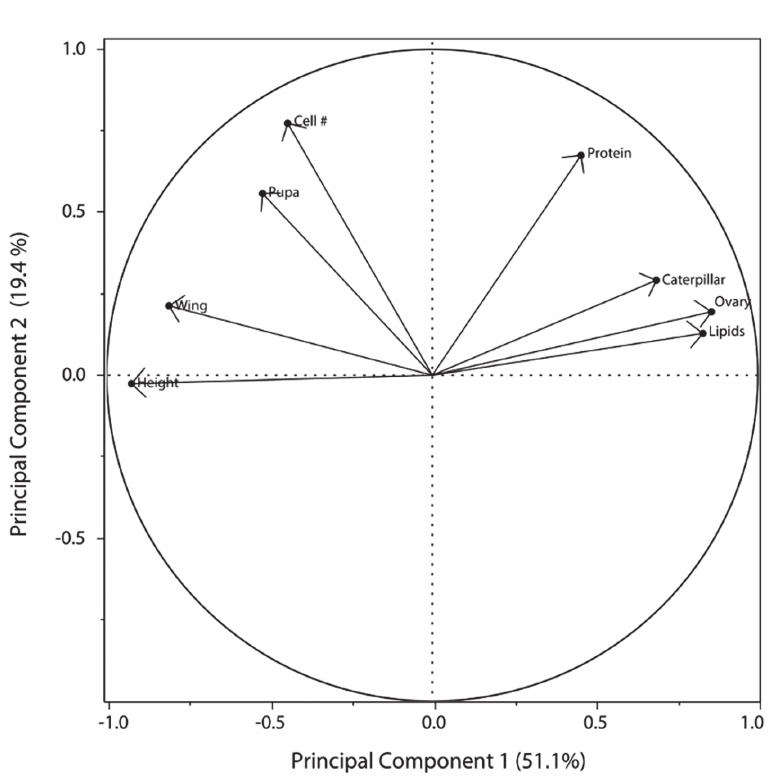
Fig 4. Loadings plot of PC1 versus PC2 for the two main principal component analysis obtained in the PCA